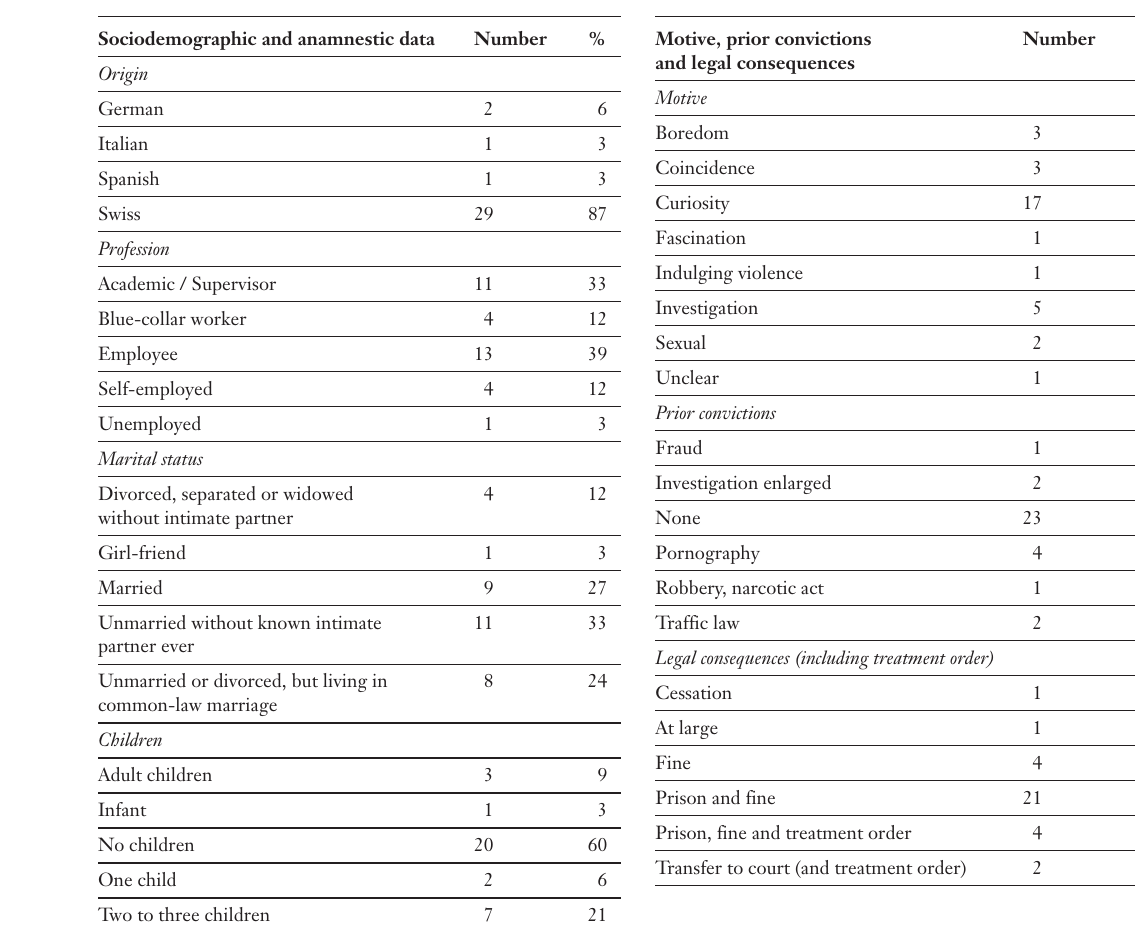
Relevant sociodemographic data of the 33 offenders. Criminological